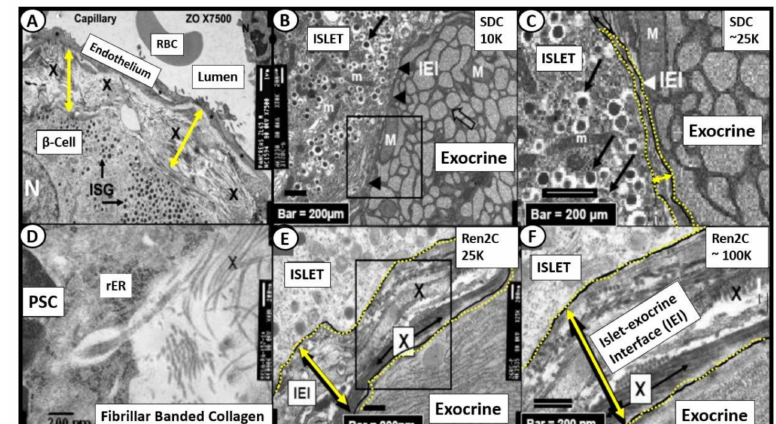
Figure 7. Intra-islet pericapillary and peri-islet (islet-exocrine interface) fibrosis. (Panel ( A )) depicts the widening and early peri-capillary fibrosis in the Zucker obese male model of insulin resistance, obesity and impaired glucose tolerance at 12 weeks of age. (Panels ( B , C )) demonstrate the close association of the islet-exocrine interface, with only slight widening at even high magnification between the exocrine and endocrine pancreas in the male control Sprague–Dawley control (SDC) model at 10 weeks of age. (Panels ( E , F )) demonstrate a marked widening at higher magnification as compared to the SDC model in B and C in addition to the accumulation of collagen (X). Importantly, (Panel ( D )) depicts the extrusion of collagen from a pancreatic stellate cell (PSC) in the Ren2 model at 10 weeks of age; scale bar = 200 nm. IEI = islet-exocrine interface; ISG = islet secretory granule; M and m = mitochondria; PSC = pancreatic stellate cell; RBC = red blood cell; rER = rough endoplasmic reticulum; X = collagen within the widened